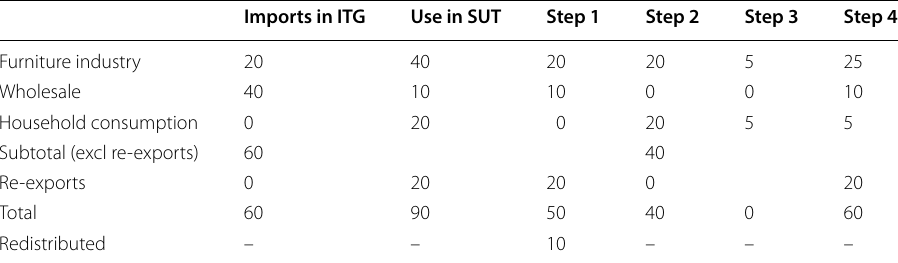
Table 5 Example of the distribution of imports of a product by destination